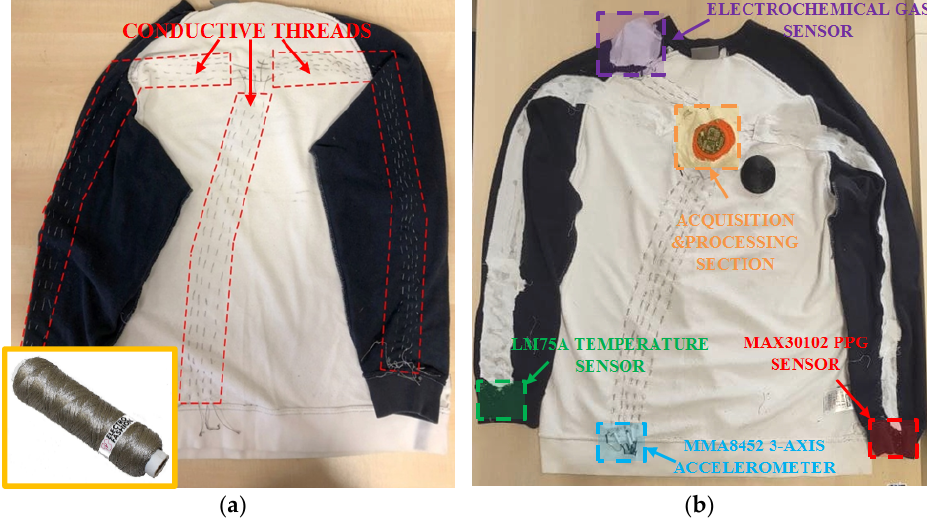
Figure 5. Images of the garment interior: electrical connections sewn to the fabric using stainless steel thread ( a ) and the distribution of sensors and electronic modules ( b ). Later, the electronic connections were insulated using a flexible silicone-based glue.